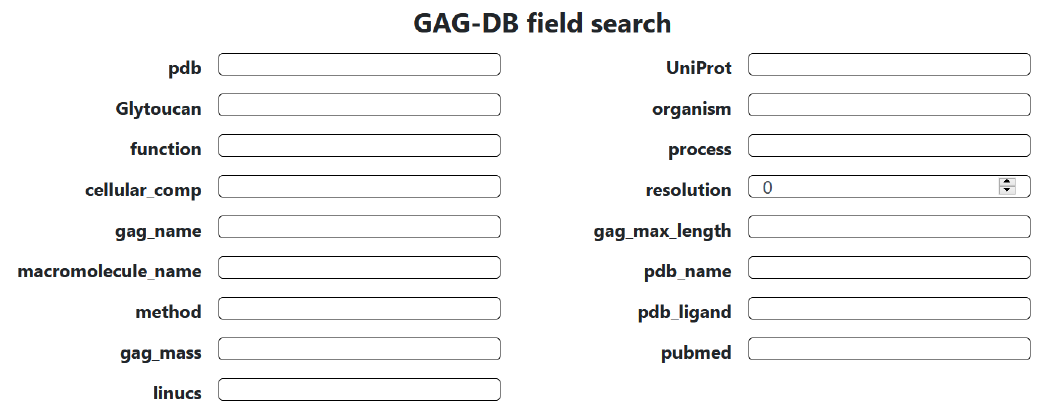
Figure 2. Multiple criteria of the advanced search in the GAG DB database.